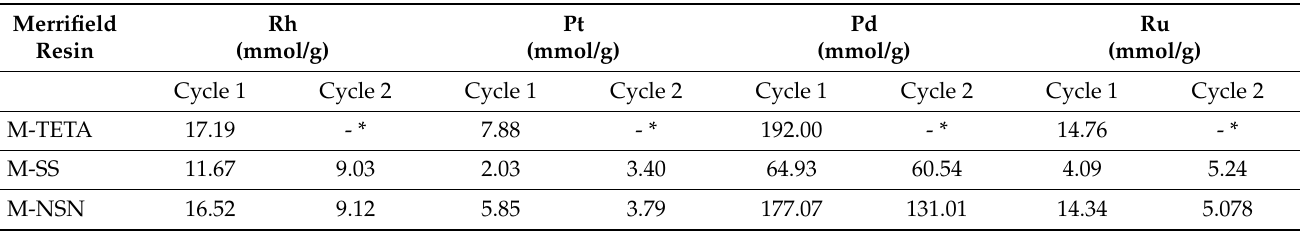
Figure 8. Loading capacities of the functionalized Merrifield resins for Pt, Pd, Rh and Ru at a flow rate of 0.5 mL/h for Cycle 1. Table 2. Loading capacities of platinum group metals extracted using functionalized Merrifield resins M-TETA, M-SS, and M-NSN.